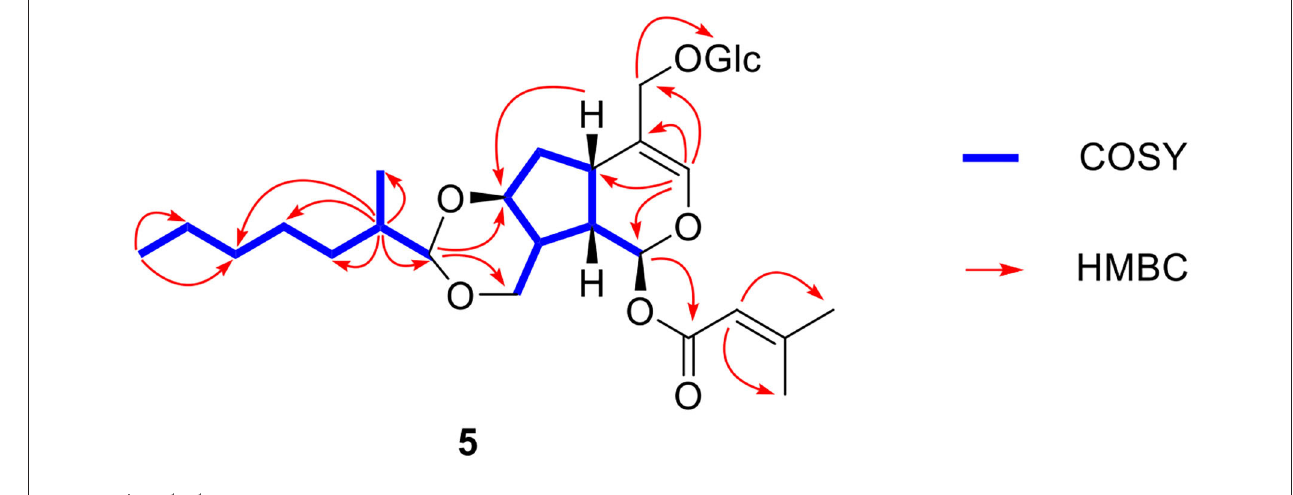
FIGURE 8 | Key 1 H- 1 H COSY and HMBC correlations of compound 5.